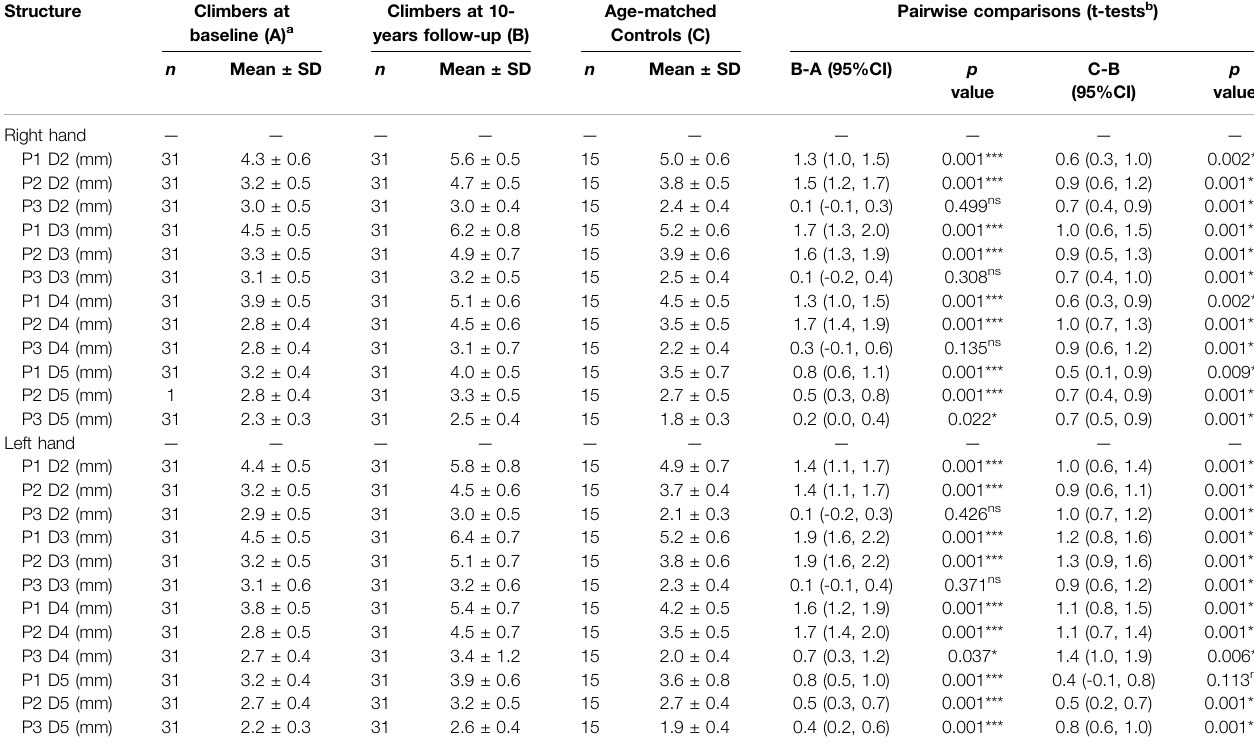
TABLE2| Descriptiveandinferentialstatisticsforthebonethicknessatphalanx1 – 3ofbothhandsanddigitsII-Vforclimbersatbaselineandat10yearsfollow-up,aswellas their age-matched controls. Structure Climbers at Climbers at 10- baseline (A) a years follow-up